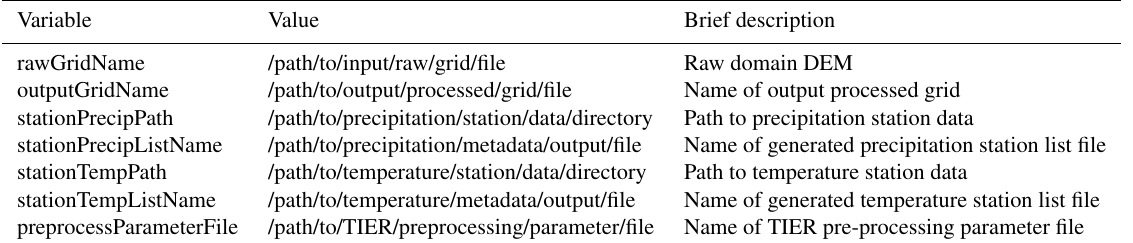
Table 2. Terrain pre-processing control file.